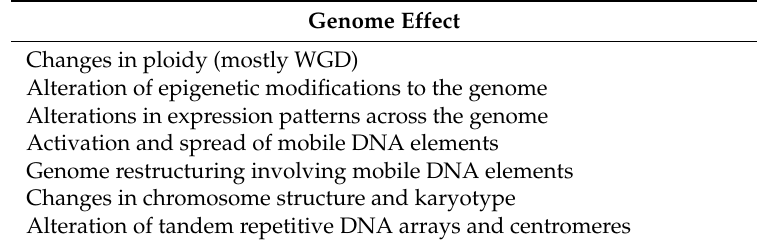
Table 5. Genomic consequences of experimental interspecific hybridization in plants and animals